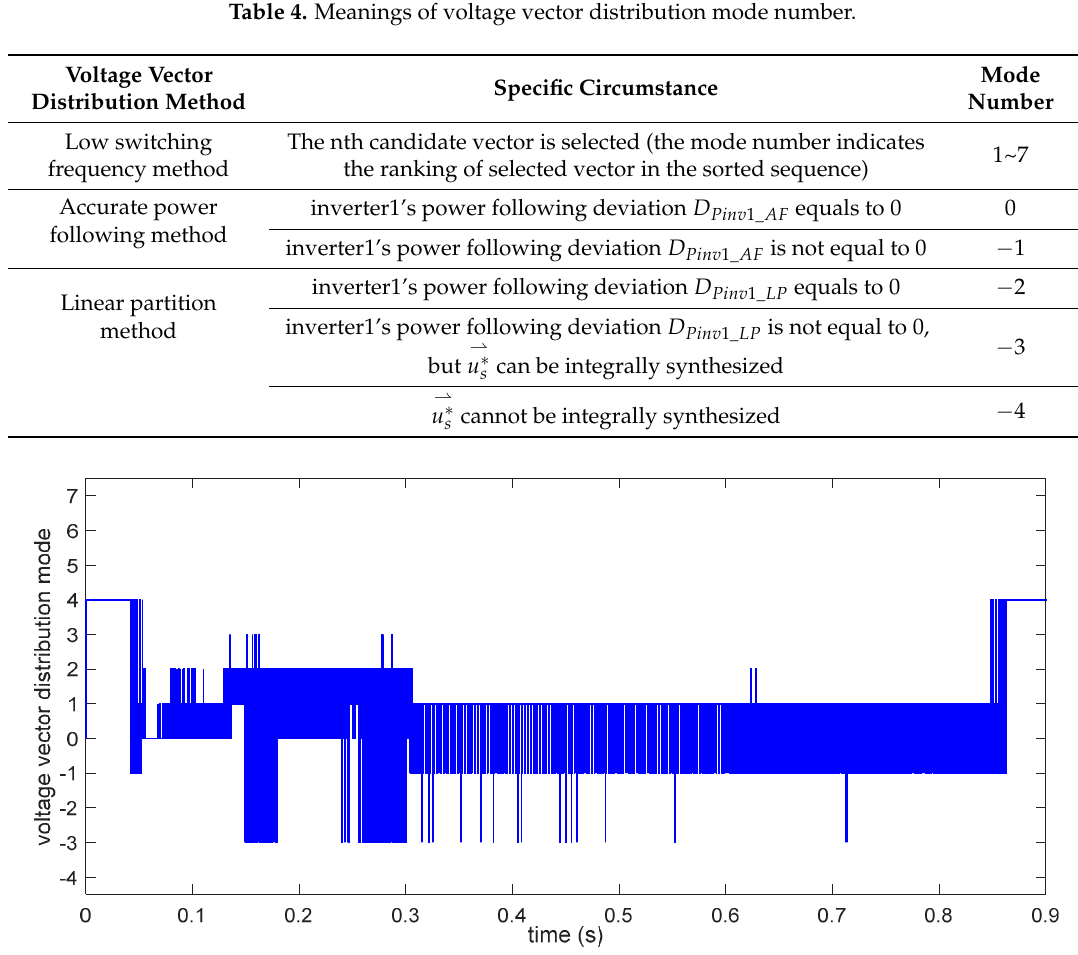
Table 4. Meanings of voltage vector distribution mode number.